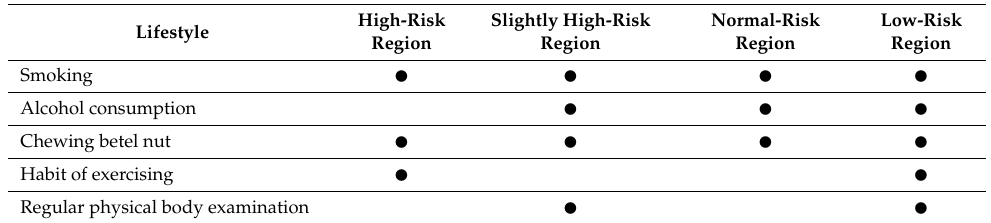
Table 3. Comparison of major risk factors for each group by lifestyle. Lifestyle